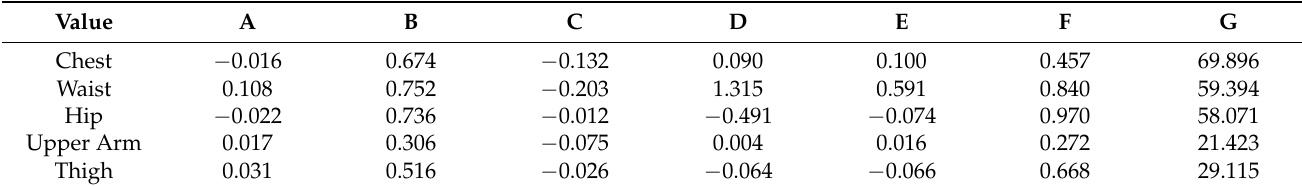
Table 9. Coefficient values for the multiple linear regression of pregnant women.